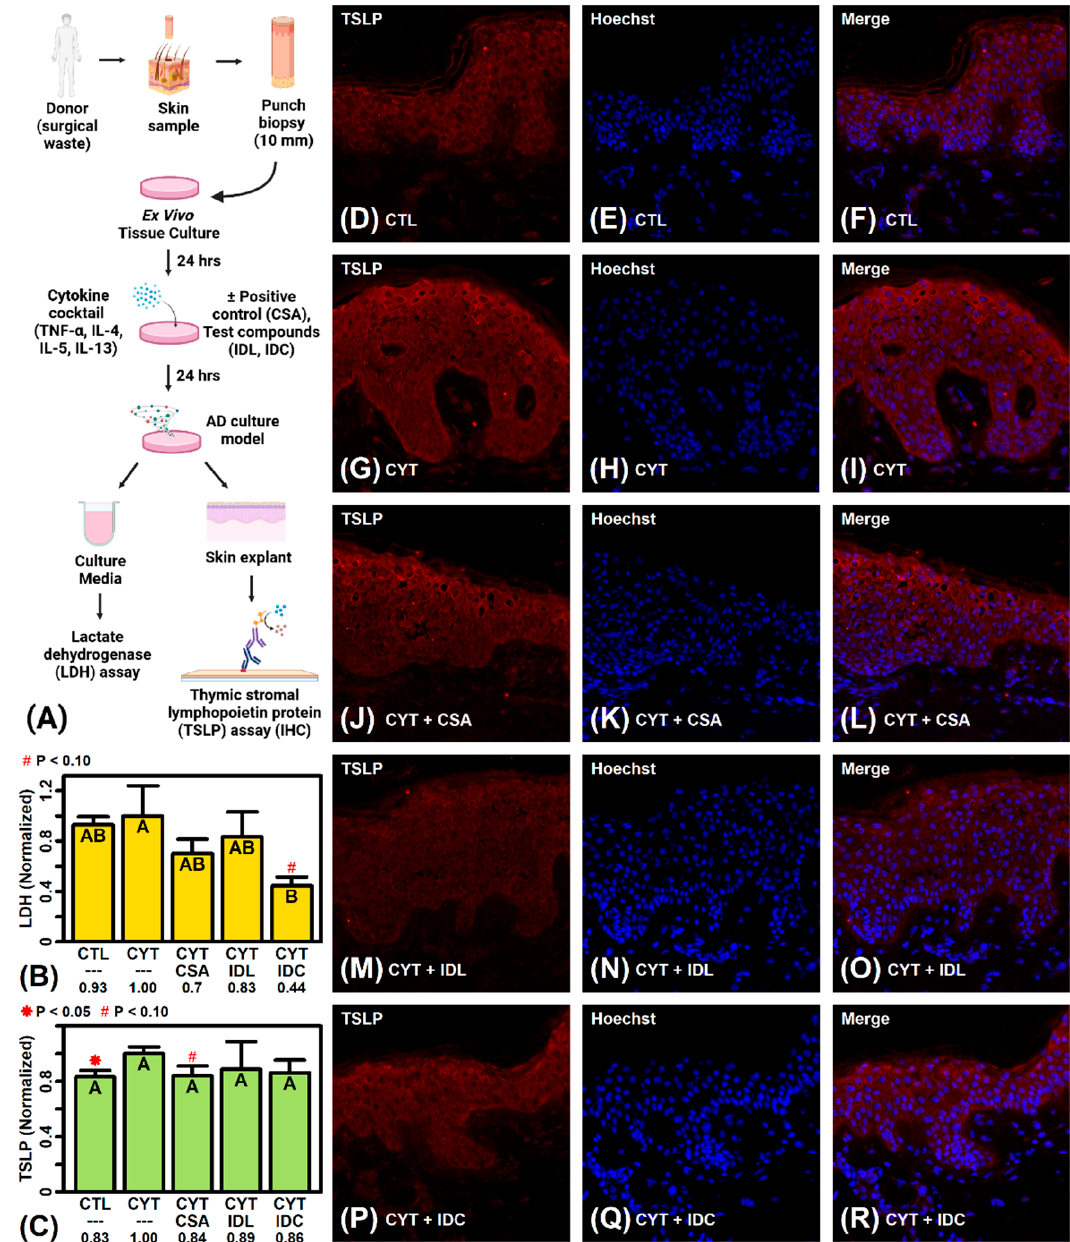
Figure 6. Effect of IDL and IDC on cell survival and inflammation in an AD explant model. ( A ) Experimental design. ( B ) Lactate dehydrogenase (LDH). ( C ) Thymic stromal lymphopoietin protein (TSLP). In ( B , C ), the average value is shown for each group ( n = 3 per treatment). Treatments that do not share the same letter differ significantly ( p < 0.05, Fisher’s least significant difference). Results from one-tailed two-sample t -tests are also shown (top margin symbols, comparison to CYT treatment). Cyclosporine (CSA) was the positive control. ( D – R ) Immunohistochemistry staining (40 × magnification). Tissues were stained for TSLP (red) and nuclei (blue) (see Methods). The cytokine cocktail led to a significant 17% increase in TSLP production ( p =